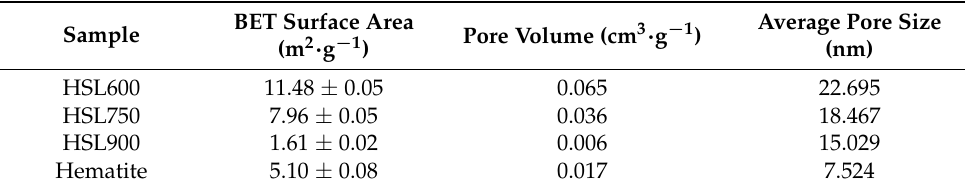
Table 1. Surface area and porosity parameters for the different samples.